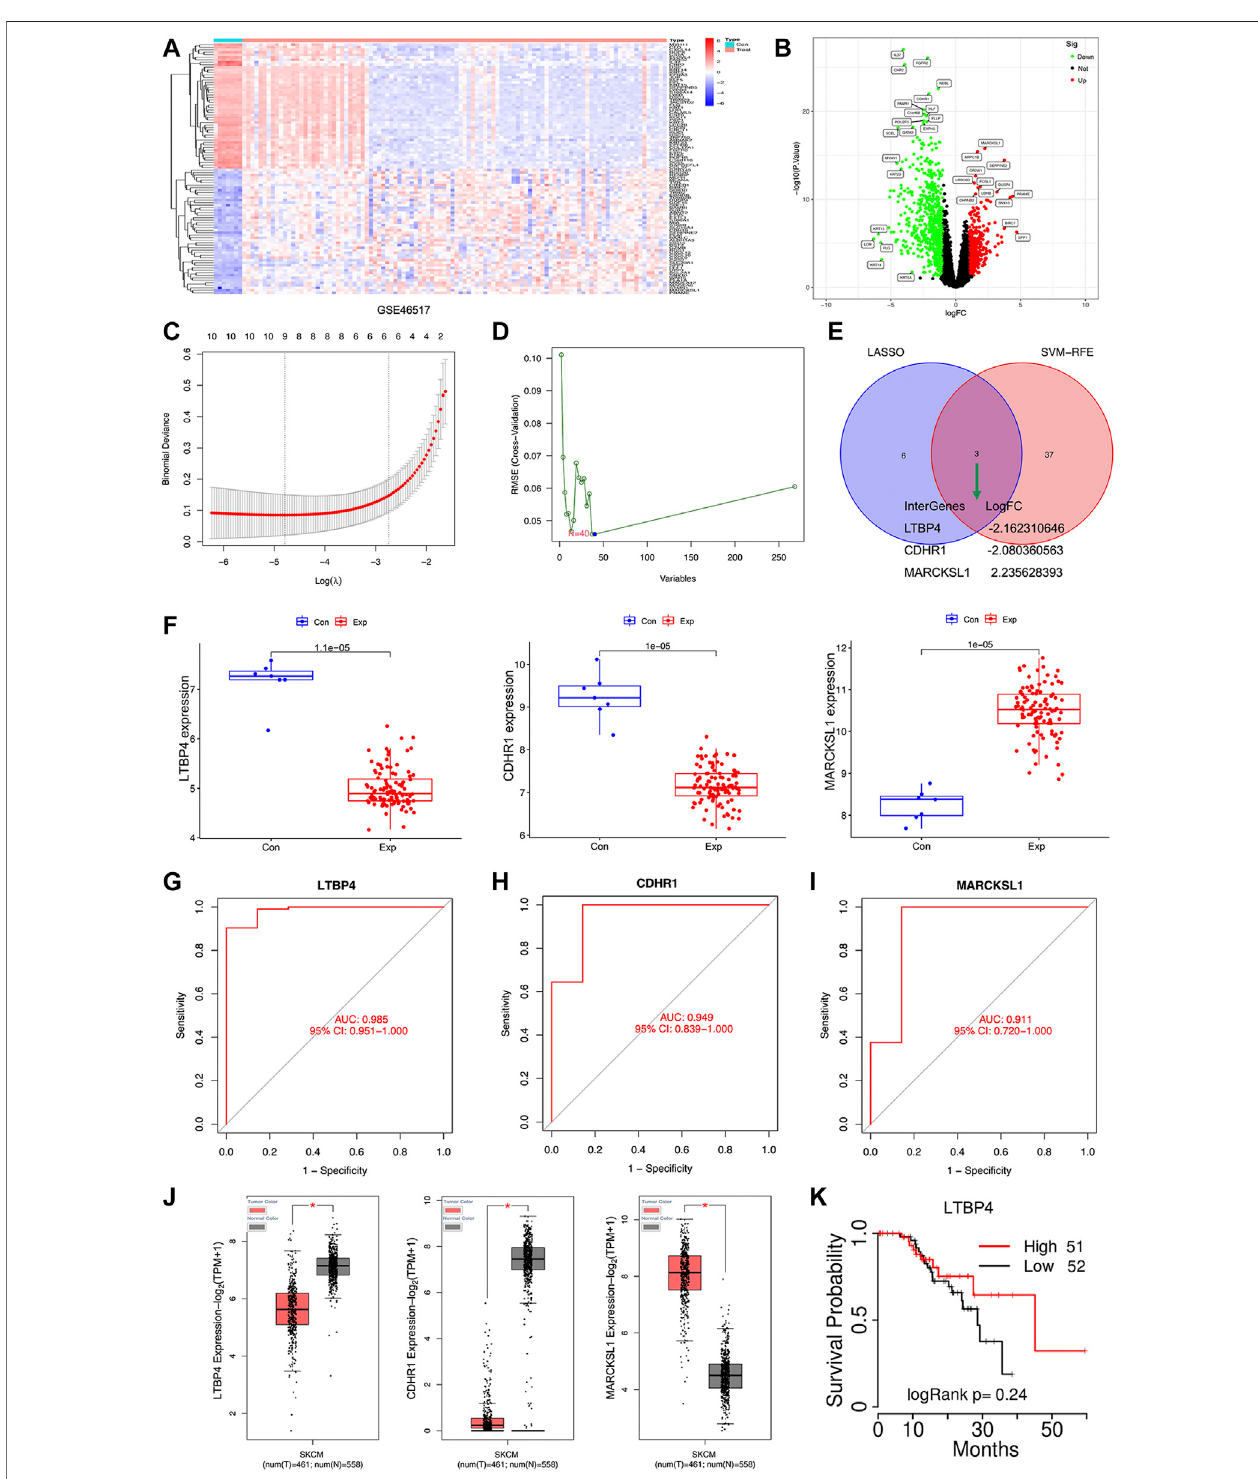
FIGURE1| BioinformaticsanalysisofDEGs.TheheatmapplotofDEGs (A) andVennplotofDEGs (B) intheGSE46517dataset. (C) Tuningfeatureselectioninthe least absoluteshrinkage andselectionoperator model. (D) Aplotofbiomarkersselectionviasupport vector machine-recursivefeatureelimination (SVM-RFE) algorithm. (E) Venn diagram demonstrating four diagnostic markers shared by the least absolute shrinkage and selection operator and SVM-RFE algorithms. (F) Validation of the expression of diagnostic biomarkers (LTBP4, CDHR1, and MARCKSL1) in the GSE46517 dataset. The receiver operating characteristic (ROC) curve of the diagnostic effectivenessofLTBP4 (G) , CDHR1 (H) , and MARCKSL1 (I) (J) LTBP4 expression wasdetermined viausing theGEPIA database (K) The survivalprobability of LTBP4 was determined via using the TCGAportal database.